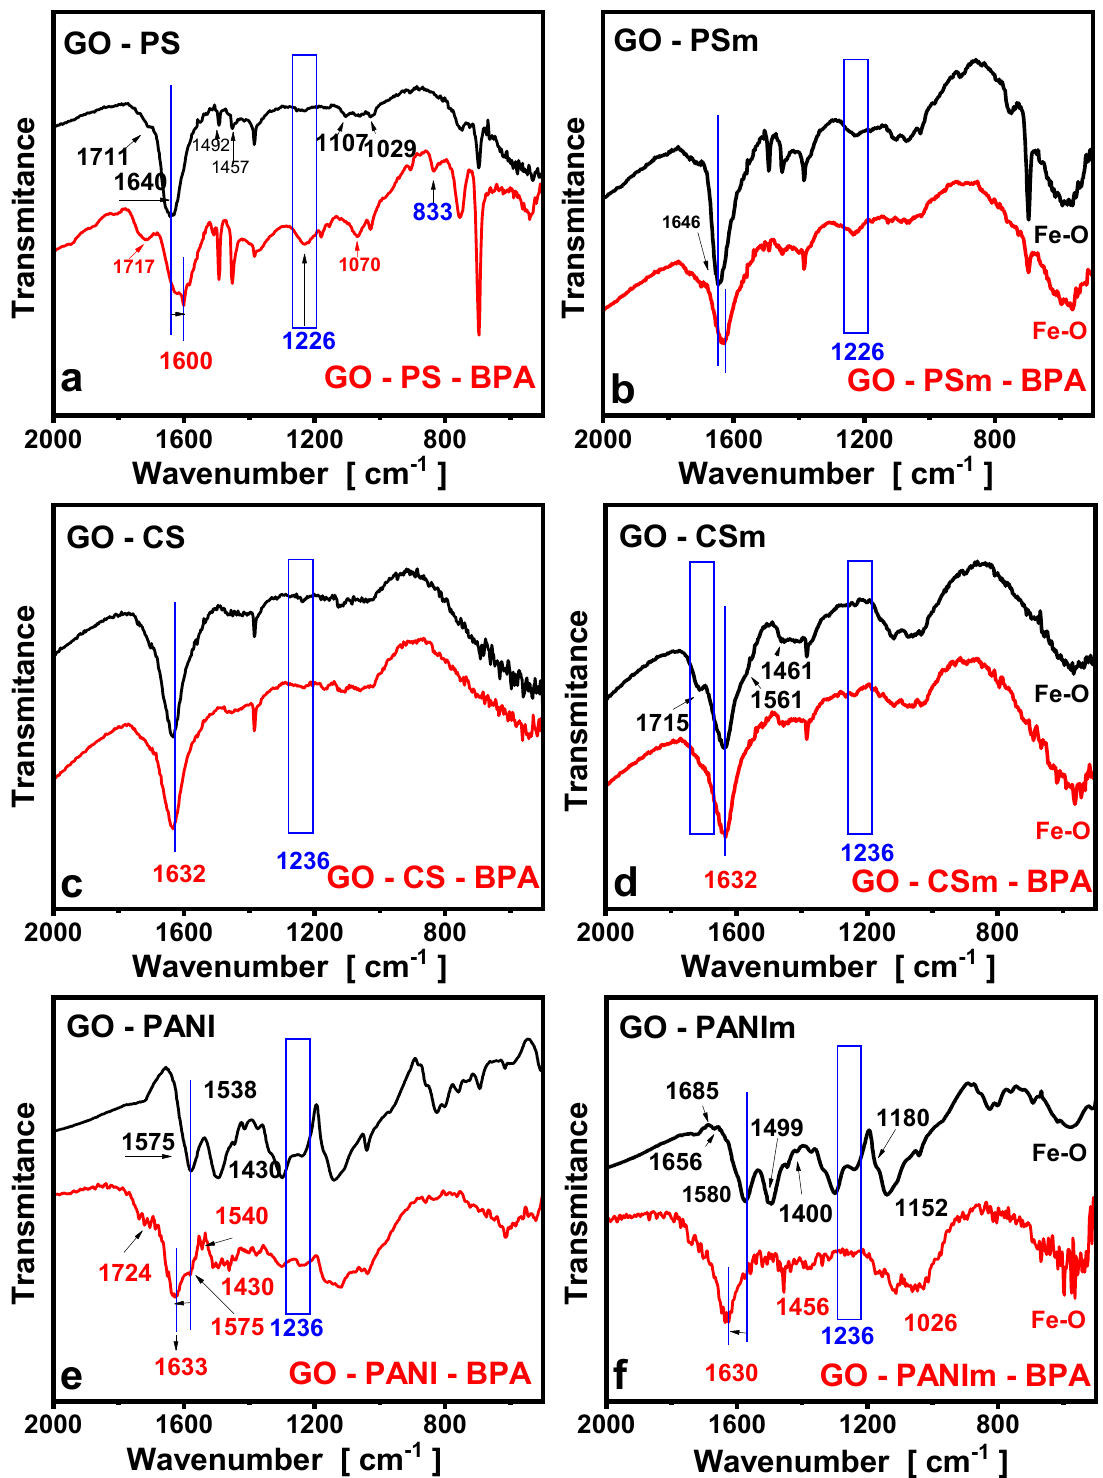
Figure 13. Fourier transform infrared (FTIR) spectrum for the materials before and after BPA adsorption. ( a ) GO-PS; ( b ) GO-PSm; ( c ) GO-CS; ( d ) GO-CSm; ( e ) GO-PANI; ( f ) GO-PANIm.